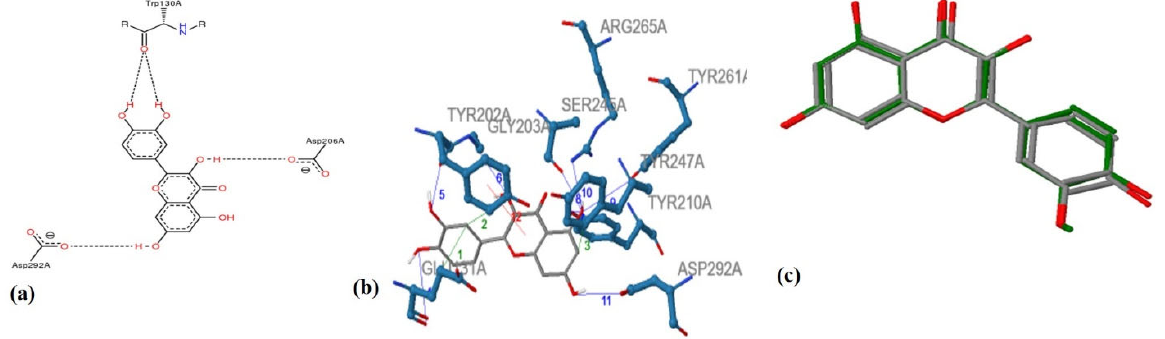
Figure 4. Representation of interactions formed between Hyaluronidase (PDB ID: 2PE4)- quercetin: ( a ) Hydrogen bonds between quercetin and Trp130A, Asp206A and Asp292A, ( b ) Hydrogen bonds, pi-stacking and Hydrophobic Interactions between Hyaluronidase-quercetin, ( c ) Ligand similarity result between quercetin (green) and naringenin (grey), as reported by ANTIAGE ‐ DB.